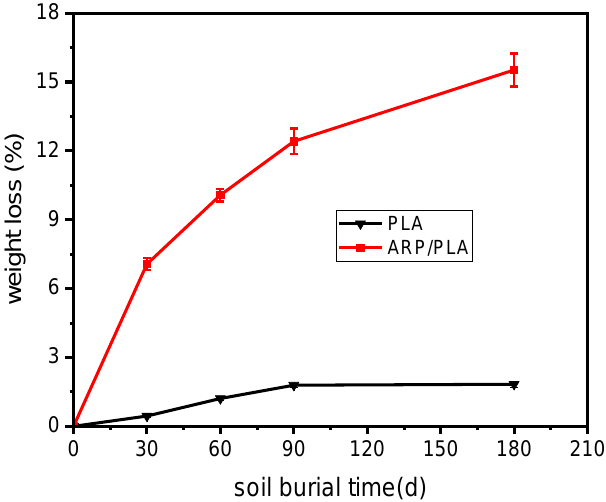
Figure 5. Weight loss curves of different specimens during degradation.